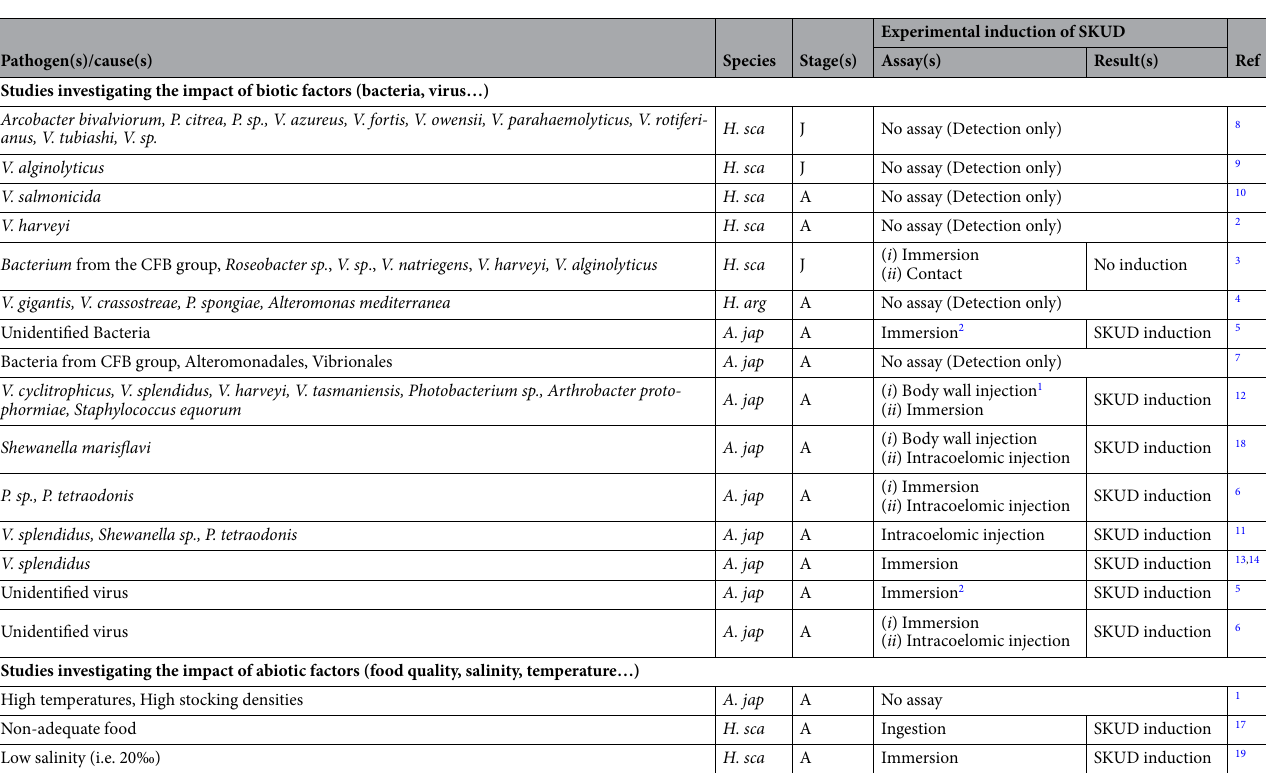
Table 1. SKin Ulceration Diseases in sea cucumbers, the associated pathogens and the potential causes. Legend: Species; H. sca. : Holothuria scabra; A. jap.: Apostichopus japonicus; H. arg.: Holothuria arguinensis; Pseudoalteromonas: P.; Vibrio: V.; Stages; J: juveniles; A: adults; Ref.: references